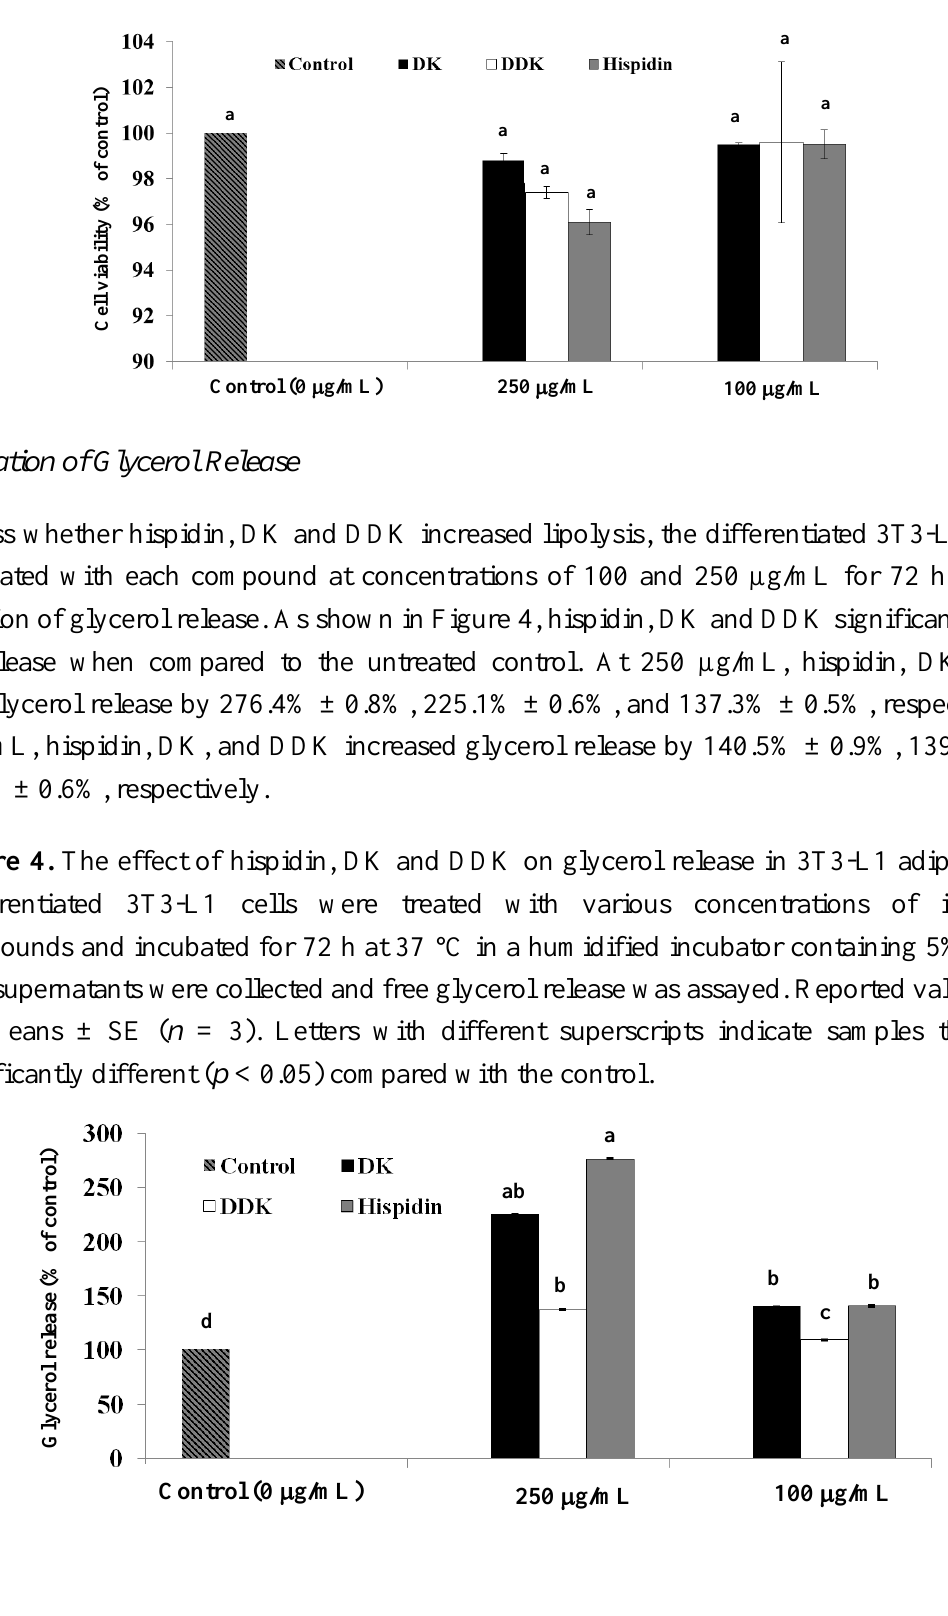
Figure 3. The effect of hispidin, DK and DDK on cell viability in 3T3-L1 adipocytes. Differentiated 3T3-L1 cells were treated with various concentrations of isolated compounds and incubated for 72 h at 37 °C in a humidified incubator containing 5% CO 2 . Data are expressed as the percent growth rate of cells cultured in the presence of samples compared with untreated control cells (mean ± SE; n = 3). Letters with different superscripts indicate samples that are significantly different ( p < 0.05) than the control.